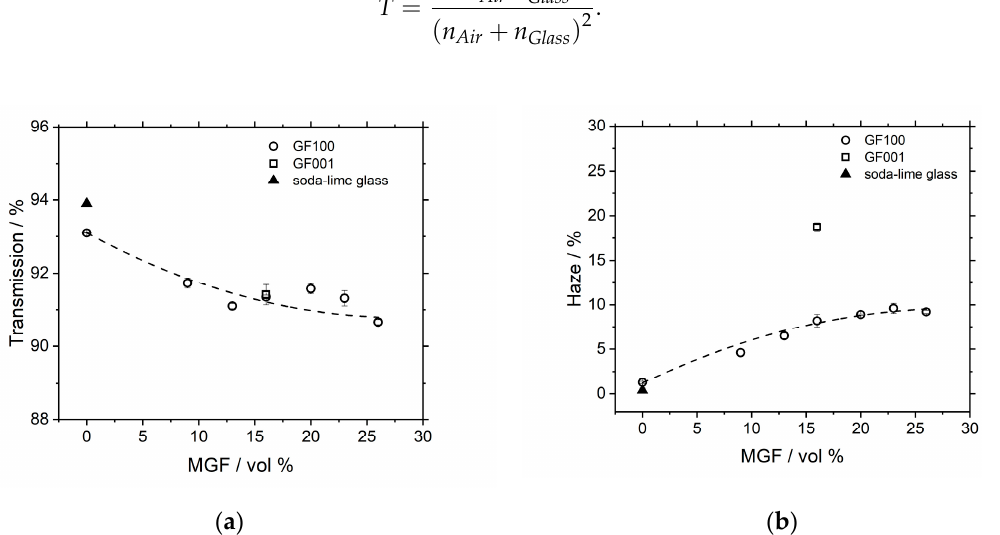
Figure 14. Transmission ( a ) and haze ( b ) in relation to volume content and size of MGF with GF100 ( d 50 = 160 µm) and GF001 ( d 50 = 30 µm). Thickness of composite was normalized to 200 µm.